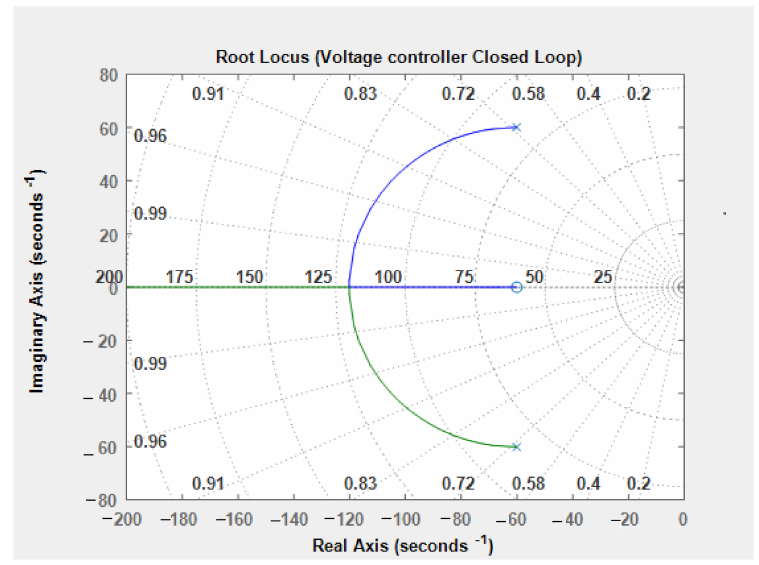
Figure 9. Root locus of the closed loop T.F of the outer voltage control system. Before starting the design of the controller for the inner current-control loop, the inductor current system stability was checked using the root locus stability, which was plotted as shown in Figure 10 for the minimum and maximum converter duty cycles. At D min = 0.40, the open loop roots r 1,2 = − 6.97 ± 826.82i, and at D max = 0.95, r 1,2 = − 6.97 + 68.55i. Varying the duty cycle from 0.4 to 0.95, the real part of the roots is usually negative; at constant value of about − 6.97, only the imaginary parts change with the different values of the converter duty cycle, in which the current system of the CCM-PFC converter is absolutely stable in open loop with the operating range of the converter duty cycle